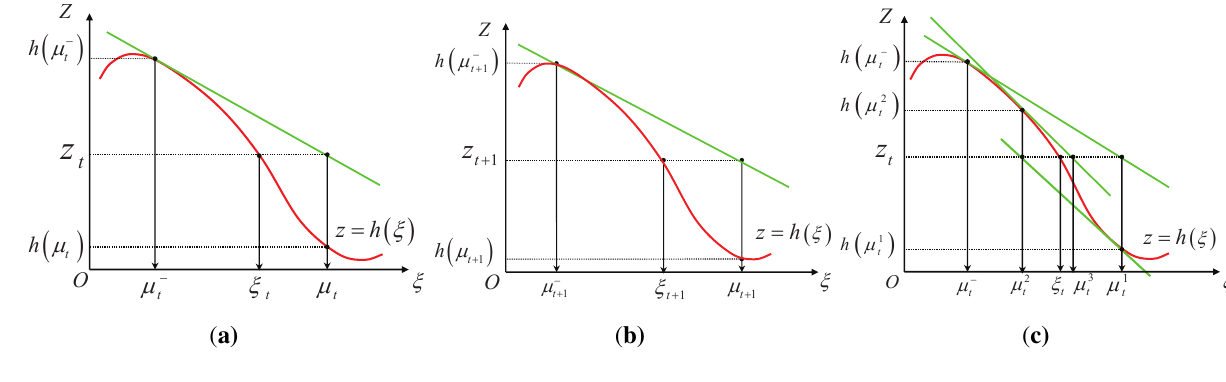
( a ) Estimate error at time t ; ( b ) estimate error at time t ` 1 ; and ( c ) the iterative